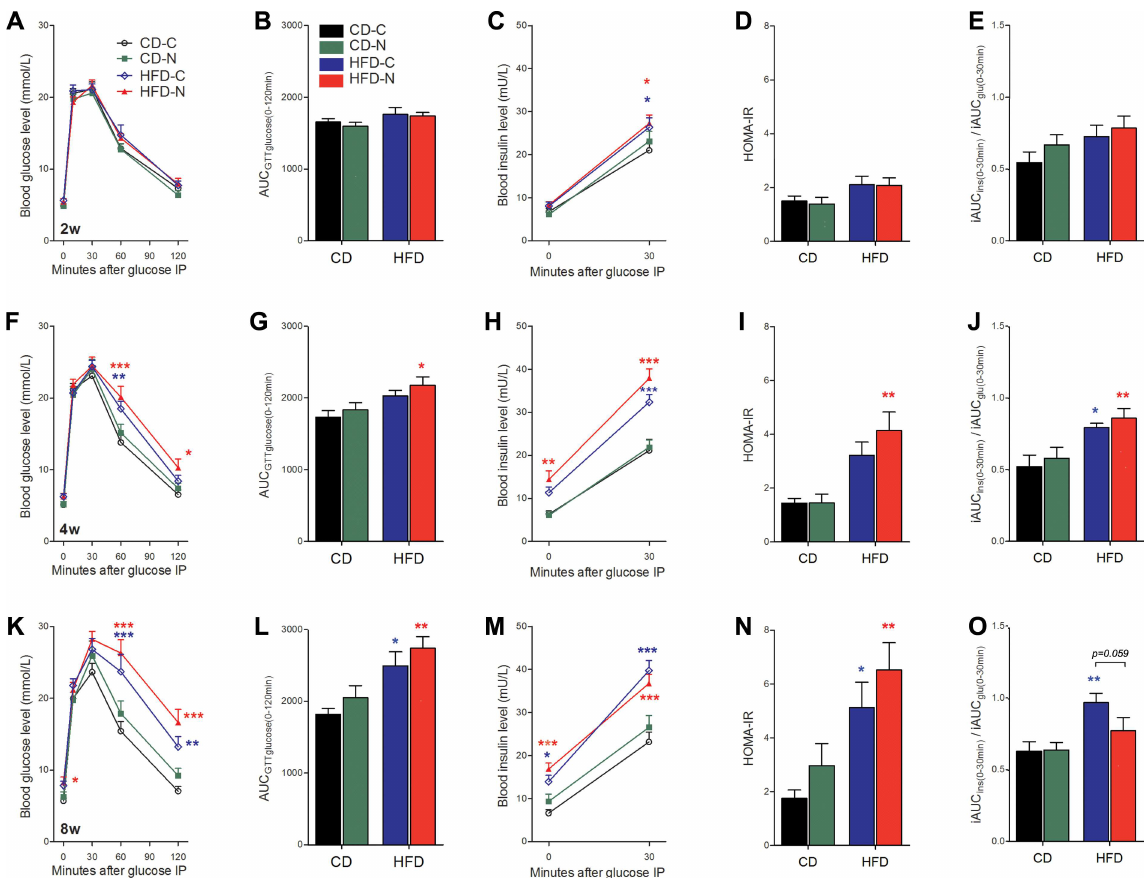
Fig 1. Effect of noise exposure on glucose tolerance and insulin response to glucose challenge in mice. (A, F, K) Blood glucose levels (BGL) recorded during the IPGTT in 16 h-fasted mice, performed after 2 weeks (A), 4weeks (F) and 8weeks (K) of treatment. (B, G, L) The corresponding results of A (B), F (G) and K (L) analyzed by area under the curve, i.e., AUC GTTglucose . (C, H, M) The serum insulin levels prior to (0 min) and 30 min after glucose injection (30SI) during the IPGTT corresponding to A (C), F (H) and K (M). (D, I, N) The homeostasis model of insulin resistance (HOMA-IR) derived from IPGTT corresponding to A (D), F (I) and K (N). (E, J, O) The iAUC Ins(0–30) /iAUC Glu(0–30) derived from IPGTT corresponding to A (E), F (J) and K (O). The values are presented as the means ± SEM of 8 mice per group. The differently-colored asterisks relate to comparisons between the color-matched group and the CD-C group determined using Bonferroni’s post hoc test following a repeated two-way ANOVA (A, F, K, C, H, M) or Tukey’s post hoc test following a one-way ANOVA (all other panels). The number of asterisks indicates the level of significance: (cid:3) p < 0.05, (cid:3)(cid:3) p < 0.01 and (cid:3)(cid:3)(cid:3) p < 0.001.